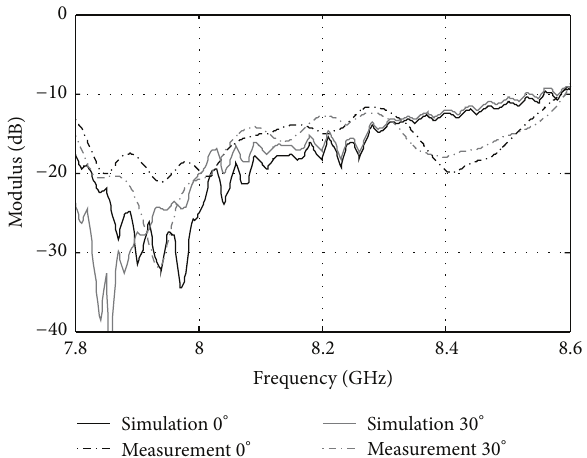
Figure 13: Simulated and measured matching coefficients of the global system for the second configuration: (a) broadside direction and (b) 30 ∘ pointing angle.